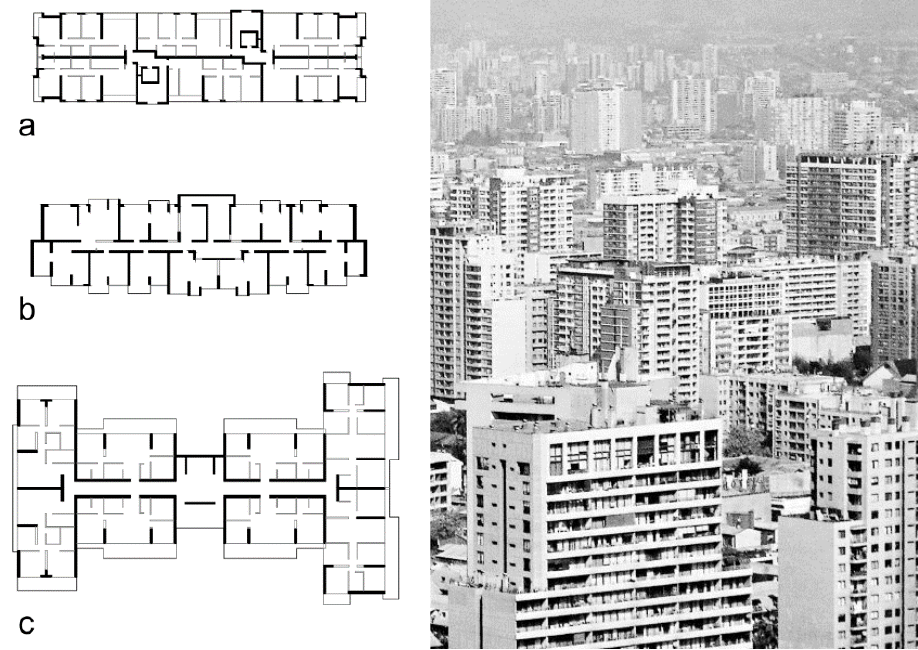
Figure 2. On the left, typical structural plans of residential buildings in Chile, a) with two vertical circulations, b) and c) with one vertical circulation and a central horizontal circulation (adapted from [44,51,52]), on the right, picture of buildings in downtown Santiago (adapted from [53]).